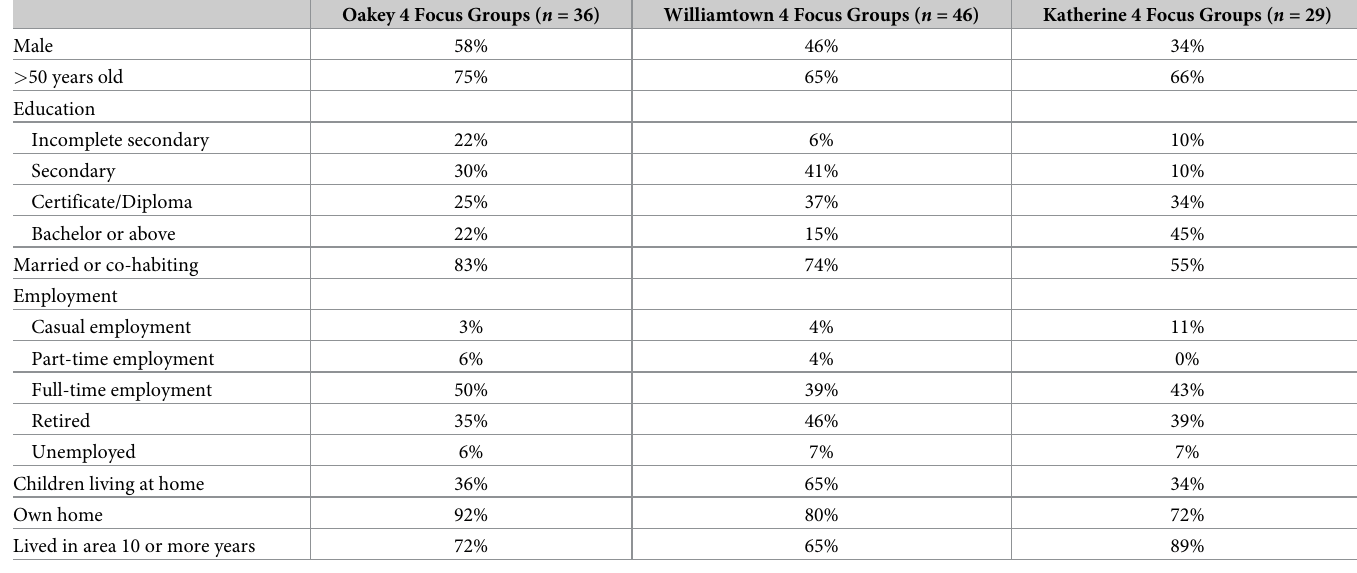
Table 1. Composition of focus group discussions, PFAS health study, Australia, February-August